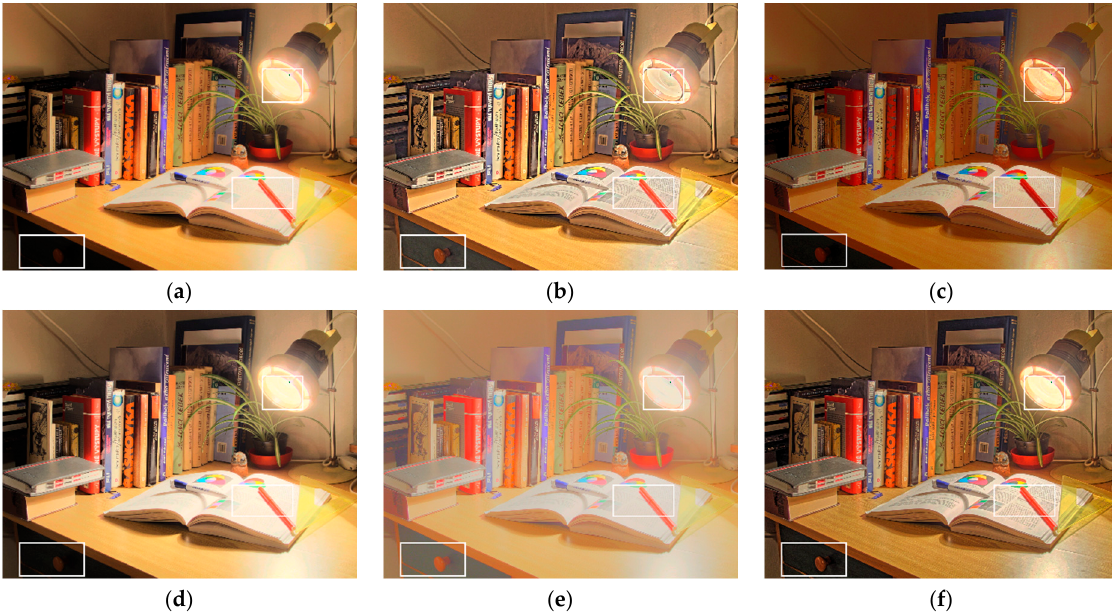
Figure 9. Results of the test image Cadik_Desk02 by ( a ) Khan et al. [9], ( b ) Gu et al. [11], ( c ) Gao et al. [28], ( d ) Ok et al. [23], ( e ) Yang et al. [21], and ( f ) the proposed method. The white rectangles indicate the areas which should be closely examined by the reader.